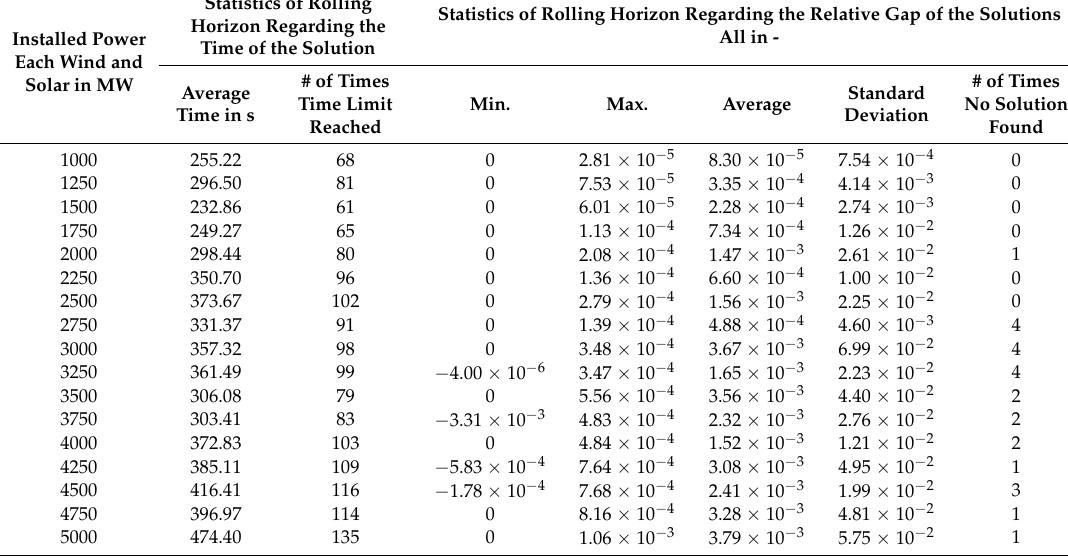
Table A5. Statistics for 2 days optimisation of MILP